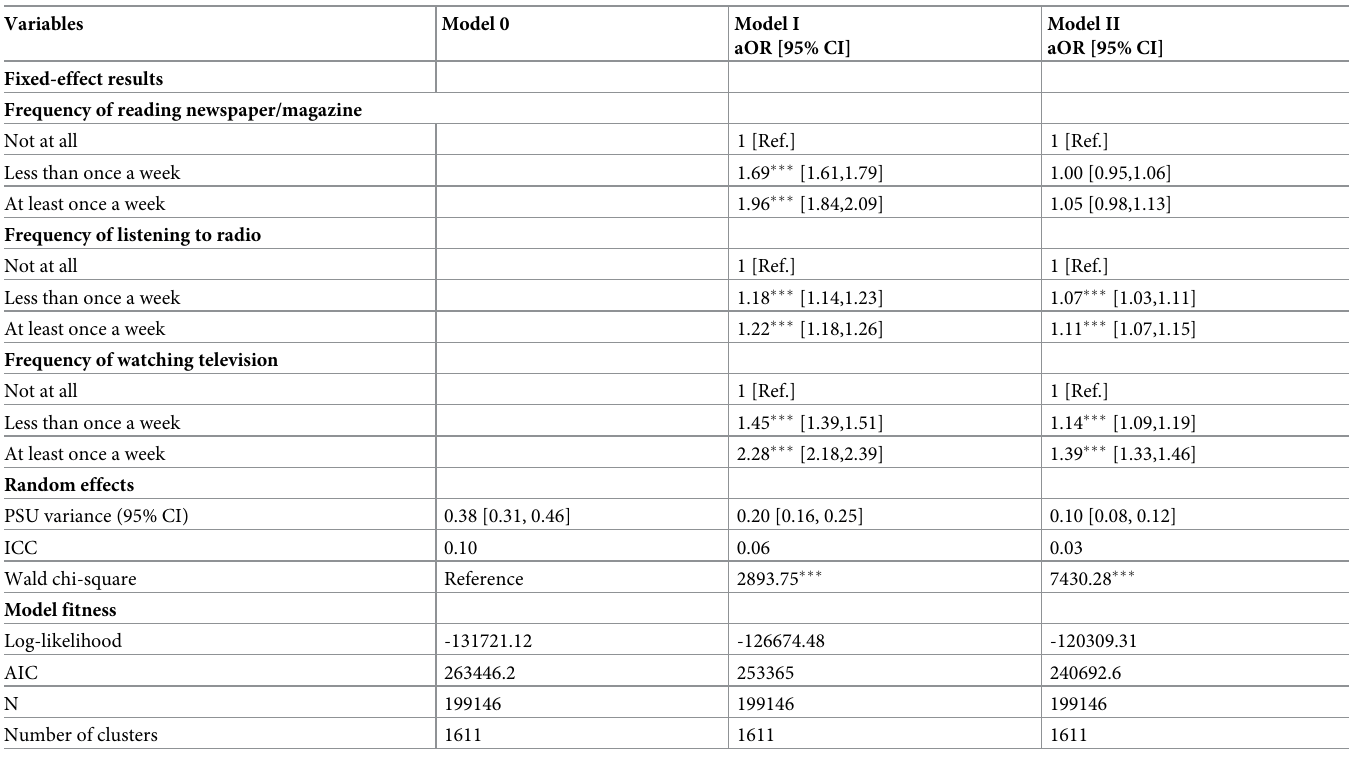
Table 3. Fixed and random effect results of the association between mass media and